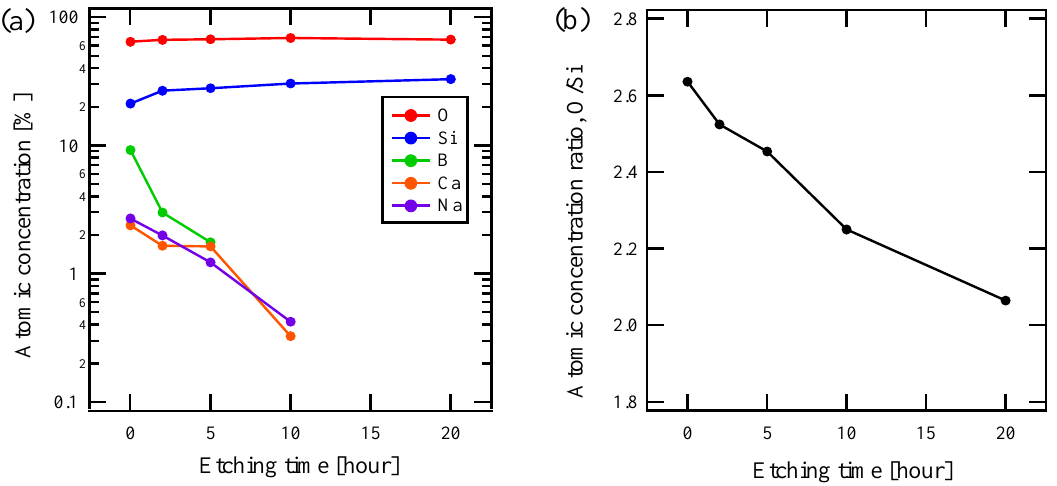
Figure 3. Chemical composition of x = 2.0 glass by X-ray photoelectron spectroscopy (XPS) measurements as a function of etching time about ( a ) atomic fraction of each element contained in glass and ( b ) atomic fraction ratio of O/Si.